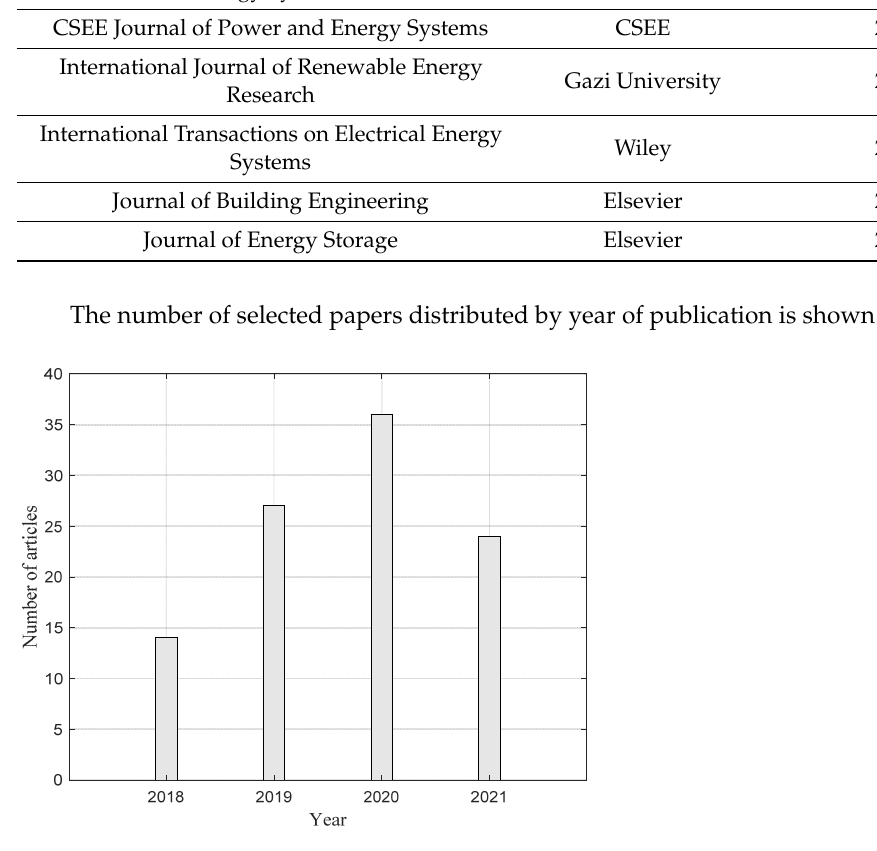
Figure 2. Number of selected articles distributed by publication years.